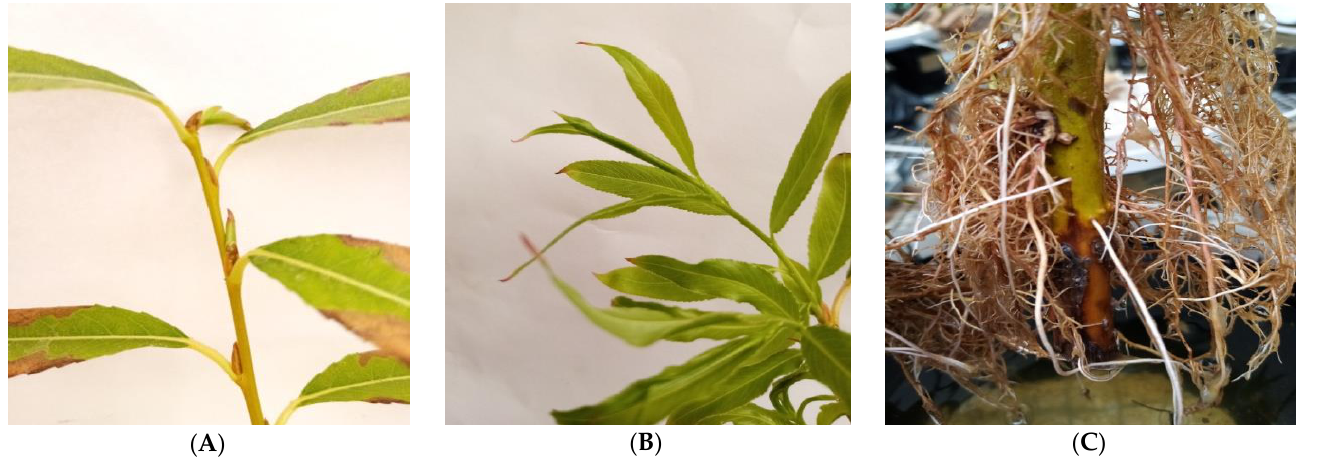
Figure 2. The appearance of a recovery phase in S. alba treated with 25% of industrial wastewater (25% IWW), which manifested as bud burst after 15 days ( A ), emergence of new leaves after 21 days ( B ) and formation of white roots after 12 days ( C ).